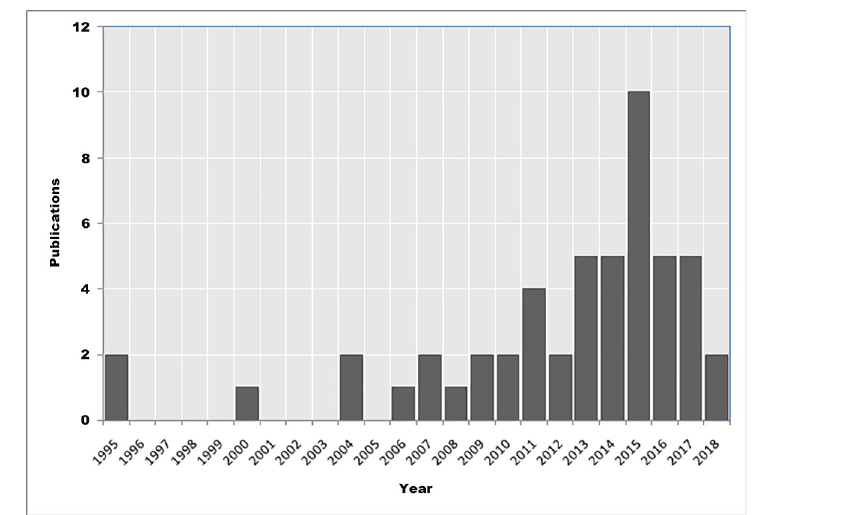
Fig 2. Number of Taenia solium publications per year in Tanzania,